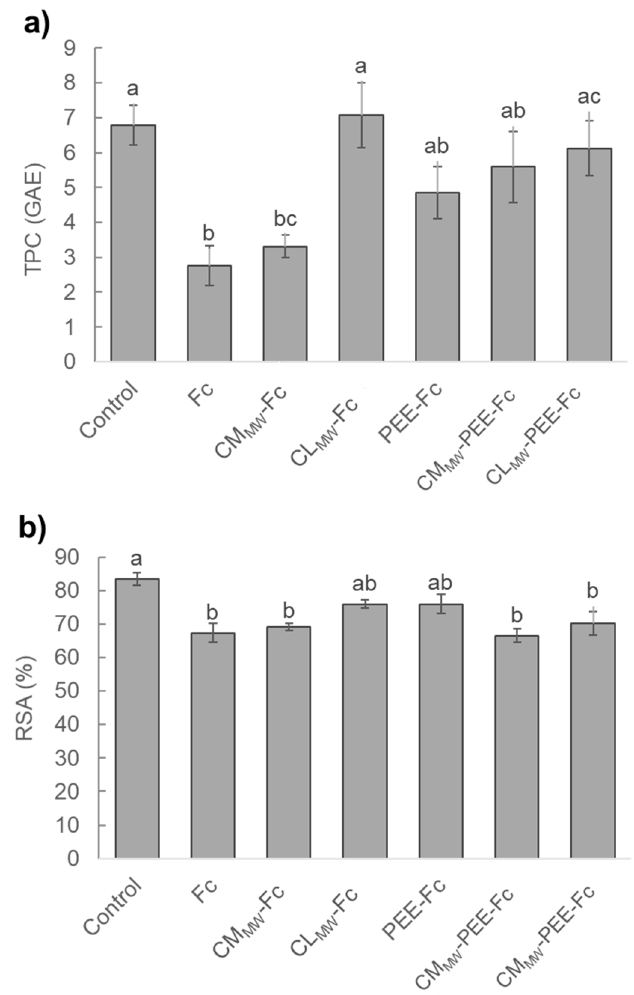
Figure 4. ( a ) Total phenolic contents (TPC) in gallic acid equivalents (GAE, mg · mL − 1 ) and ( b ) percentage of radical scavenging activity (RSA%) of P. sylvestris seedlings from control ( i ) and inoculated with Fusarium circinatum (Fc) treatments—( vii ) to ( xii )—as a function of the seed coatings at 30 days after sowing. CM MW and CL MW stand for medium and low molecular weight chitosan, respectively, PEE stands for propolis ethanolic extract. Averages with the same letter were not significantly different according to the Tukey’s HSD test ( α ≤ 0.05).